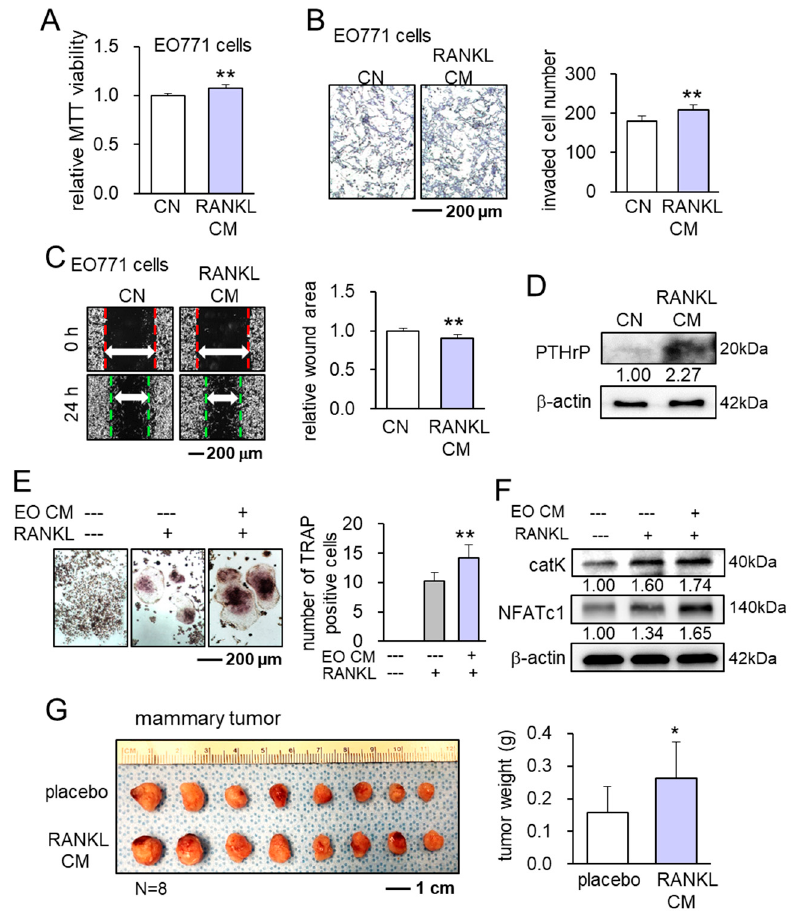
Figure 1. Vicious interactions between differentiated RAW264.7 osteoclasts and EO771 mammary tumor cells. CN = control, RANKL CM = differentiated osteoclast-derived conditioned medium (treated with 10 ng/mL RANKL and 2 ng/mL M-CSF for 2 days), and EO CM = EO771 tumor cell-derived CM. * p < 0.05 and ** p < 0.01. ( A – C ) Elevation of MTT-based viability, transwell invasion, and scratch-based migration of EO771 cells by RANKL CM. ( D ) Elevation of PTHrP in RANKL CM. ( E ) Increase in the number of TRAP-positive RAW264.7 osteoclasts by EO CM. ( F ) Elevation of cathepsin K and NFATc1 in RANKL-stimulated RAW264.7 osteoclasts in response to EO CM. ( G ) Increase in the size and weight of mammary tumors in C57BL/6 female mice.